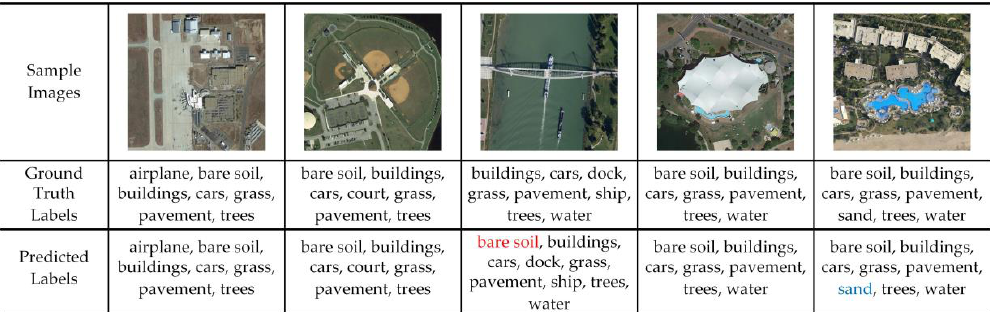
Figure 5. Sample images and predicted labels in the AID multi-label dataset. Red predictions indicate the false positives (FP), and blue predictions indicate the false negatives (FN).